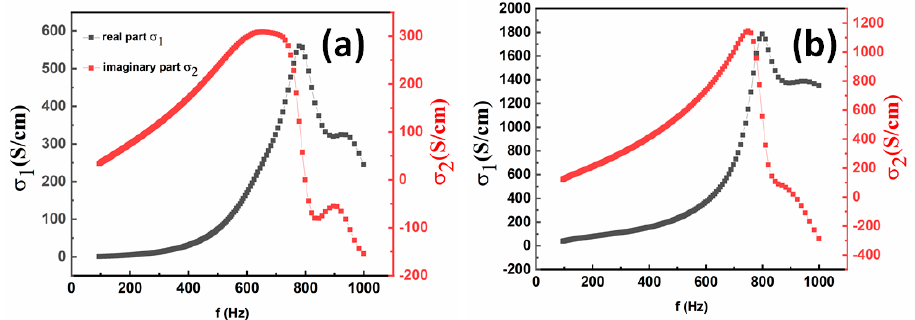
Figure 7. The optical conductivity dependence on frequency of graphene oxide ( a ) and thermally reduced graphene oxide ( b ) films on SiO 2 / Si substrates.